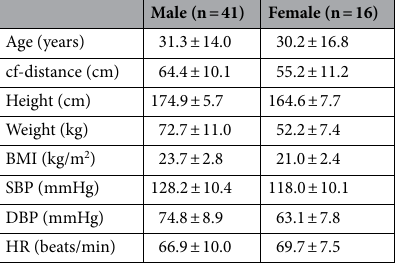
Table 2. Subject characteristics (n = 57) Mean values ±